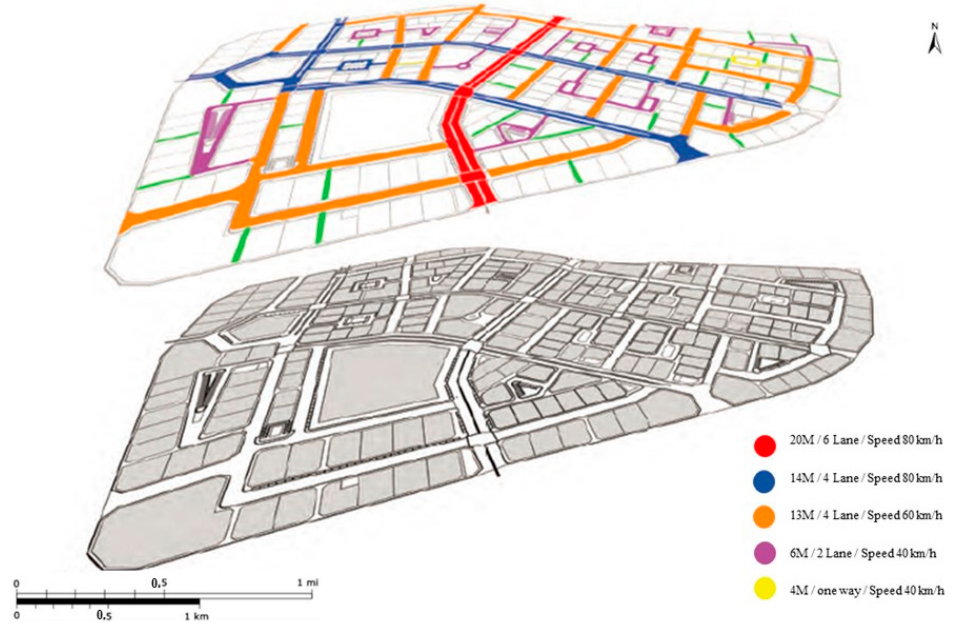
Figure 8. Road design (Source: the Authors).